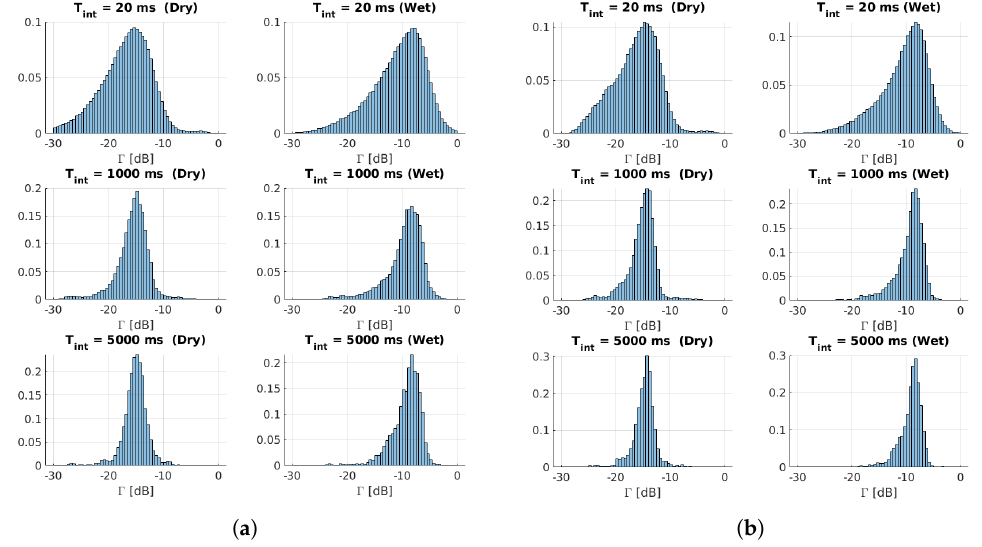
Figure 8. Normalized histogram PDFs of the MIR reflectivities retrieved at different effective integra- tion times at ( a ) L1 and ( b )